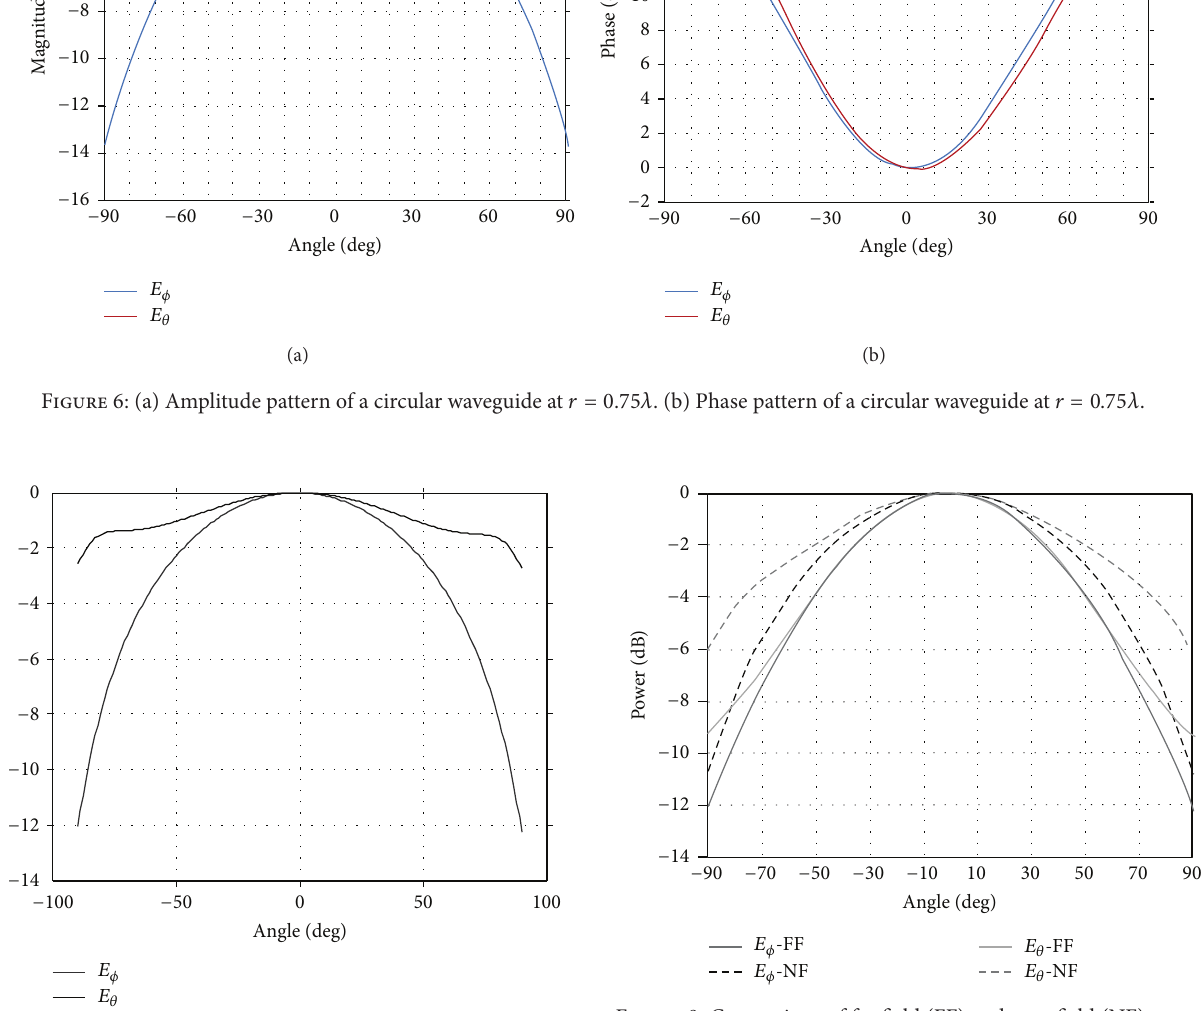
Figure 7: Radiation pattern of circular waveguide at a distance of 𝐷 2 /𝜆 .